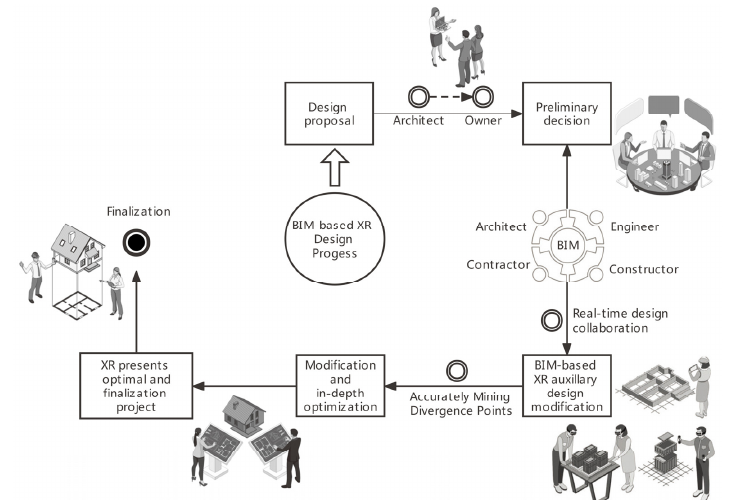
Figure 2. BIM-based XR system for design processes.